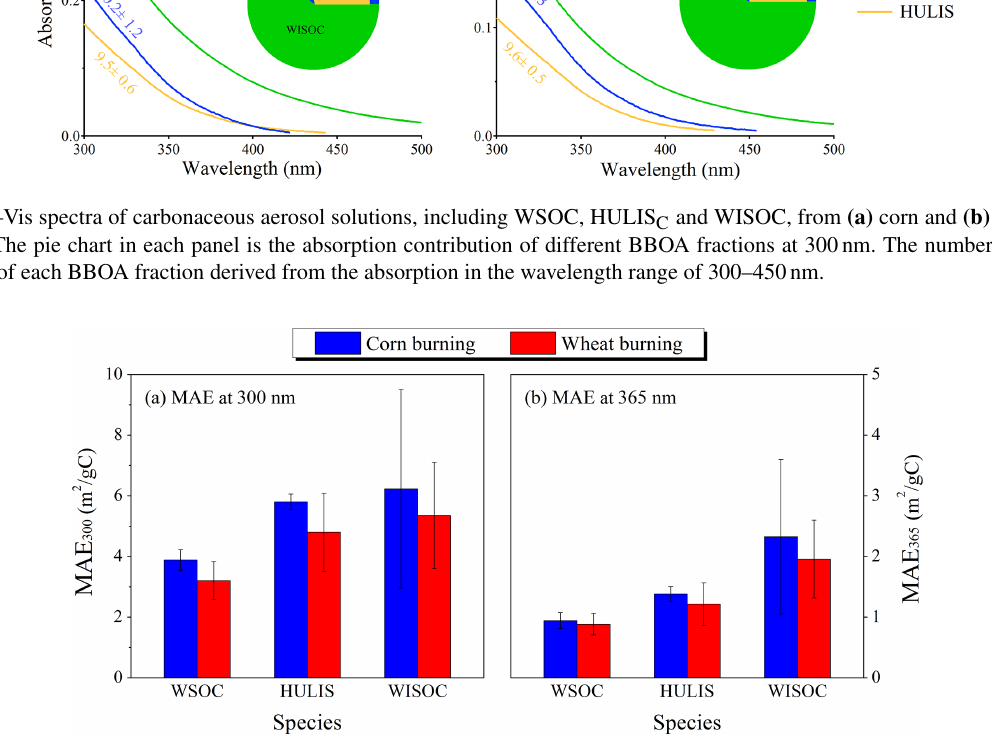
Figure 6. Mass absorption efficiency (MAE) of different organic carbonaceous aerosols, including WSOC, HULIS and WISOC emitted from corn and wheat